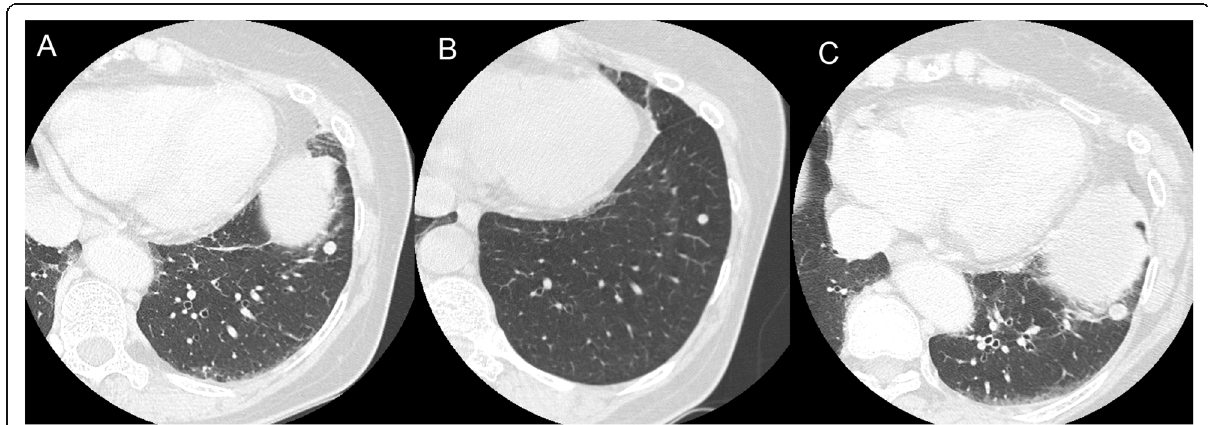
Fig. 1 Computed tomography showing a peripheral well-circumscribed pulmonary nodule in the left lower lobe. a The size was 7.0 × 6.6 mm before the thyroidectomy. b It decreased in size to 5.5 × 5.0 mm after the adjuvant radioactive iodine therapy. c It grew to 8.7 × 8.0 mm over 5 years